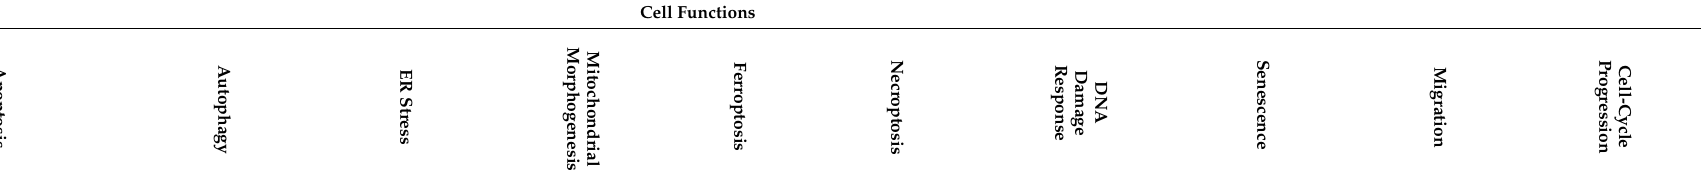
Table 6. AKT-modulated natural products that modulate cell